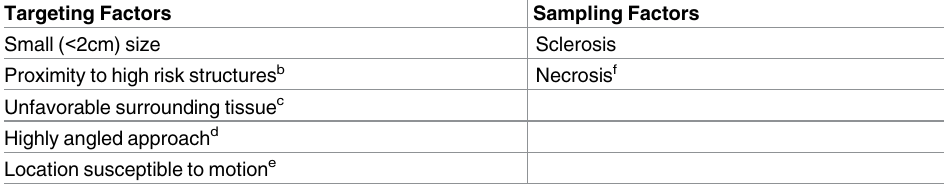
Table 1. Problematic lesion imaging characteristics affecting likelihood of adequacy score a